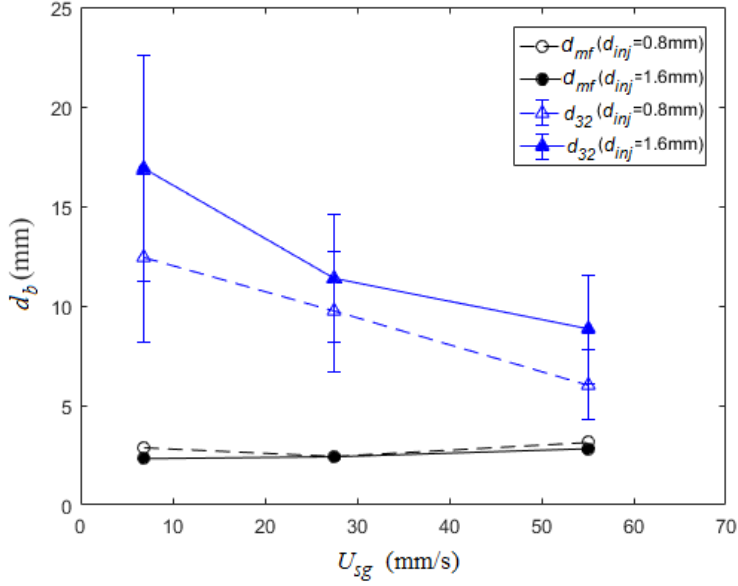
Figure 11. Bubble sizes ( d mf and d 32 ) plotted versus the superficial gas velocity varying the injector tube diameter ( D = 102 mm; P m = 600 kPa).